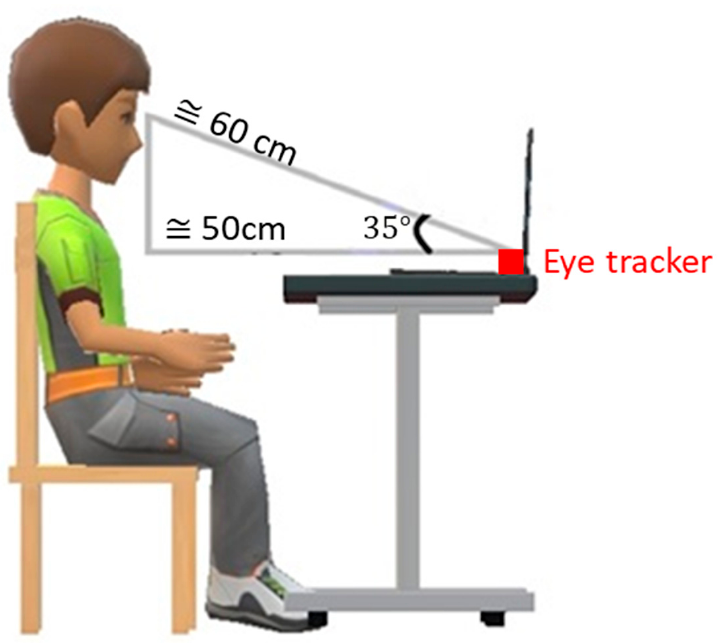
Figure 1. Illustration of the experimental setting.